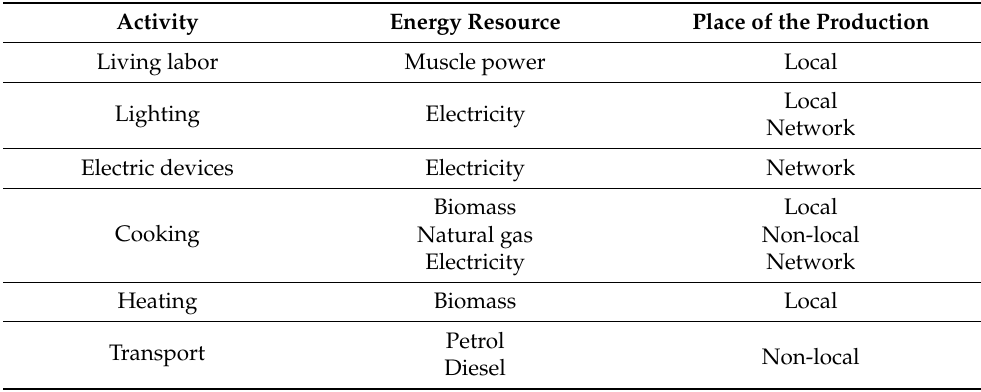
Table 3. Activities, energy resources, and place of production of small-scale